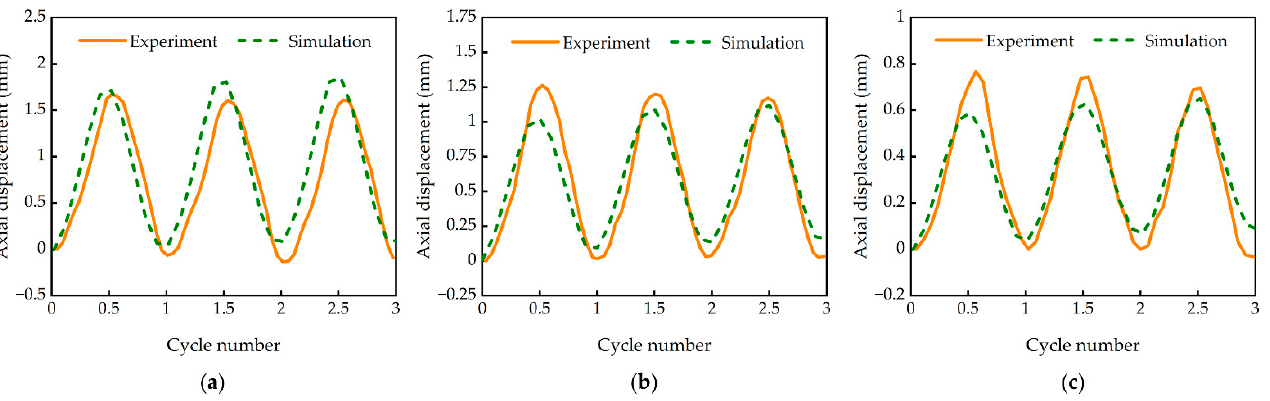
Figure 15. Experimental and simulated data of axial displacement of the helical IPMC actuator under sinusoidal signals with different frequencies: ( a ) 3 V, 0.25 Hz; ( b ) 3 V, 0.5 Hz; ( c ) 3 V, 1 Hz.